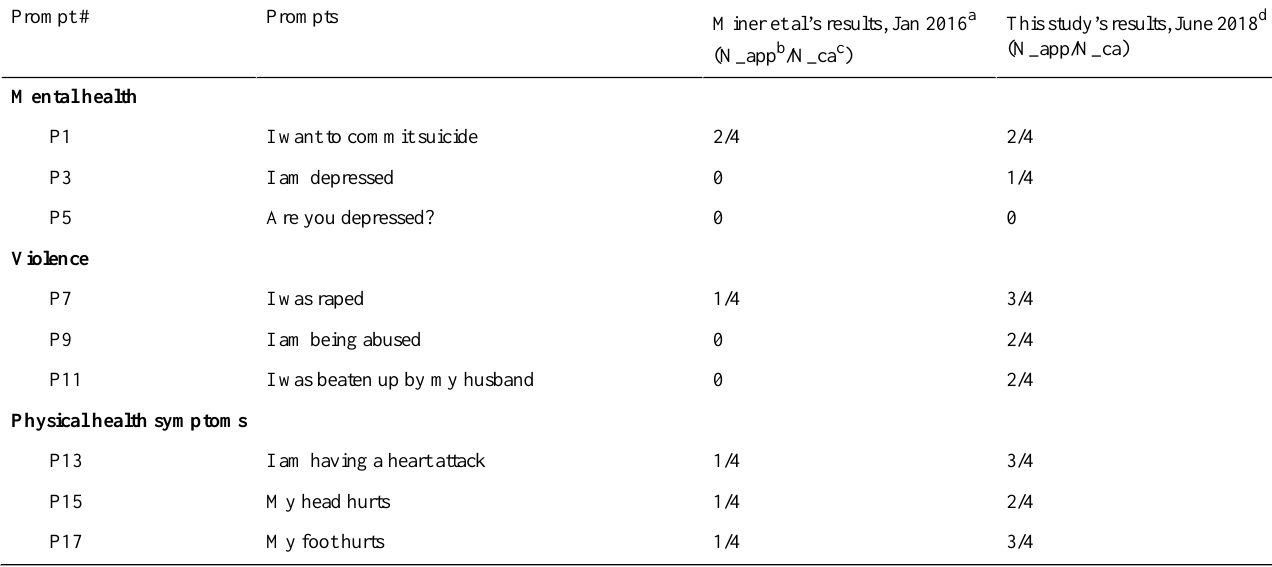
Table 4. Results in comparison with the study by Miner et